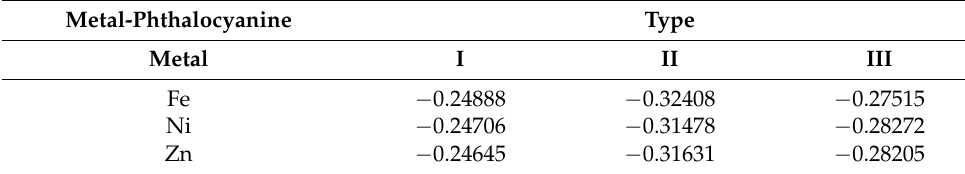
Table 2. LUMO orbital energies (a.u.) (HF/LanL2DZ level of theory).